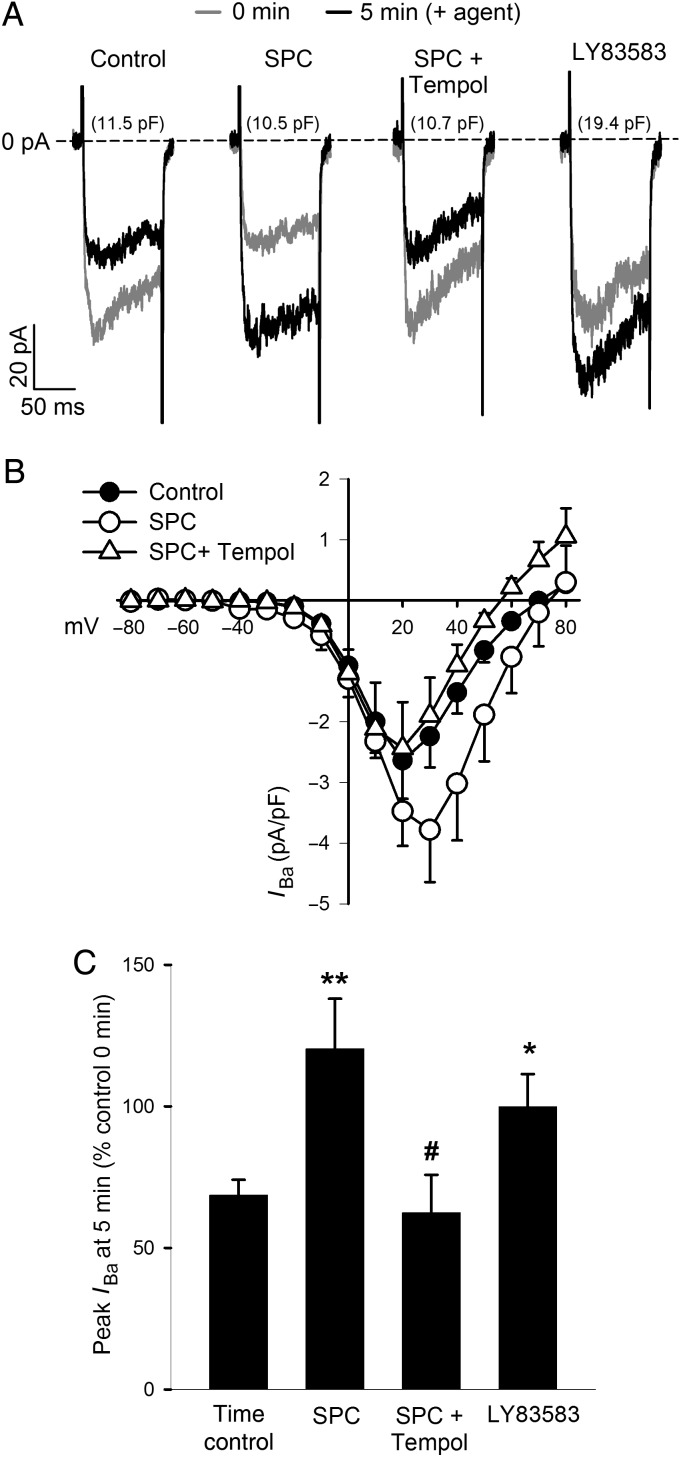
Voltage-gated calcium currents and SPC. (A) Representative whole-cell IBa currents following step to +20 mV from holding voltage from four freshly isolated MA myocytes (cell capacitance shown). Grey lines show current immediately following patching (0 min) and before addition of agent; black lines current 5 min later and in the presence of agent. Note current rundown in control trace. (B) I–V plots of IBa densities for MA myocytes from 14 rats (control, closed circles, n = 11), in the presence of 200 nmol/L SPC (open circles, n = 7), and in the combined presence of SPC and 3 mmol/L Tempol (n = 6). Further details in Methods. Bars = SEM. (C) Percentage change in peak IBa at 5 min relative to the initial control current at time 0 derived from data above. Time control showing typical IBa rundown, n = 11; SPC, n = 7; SPC + Tempol, n = 6; LY83583 (1 µmol/L, n = 6). Bars = SEM. *P < 0.05; **P < 0.001 vs. time control; #P < 0.05 vs. SPC alone; one-way ANOVA, Holm-Sidak post hoc.